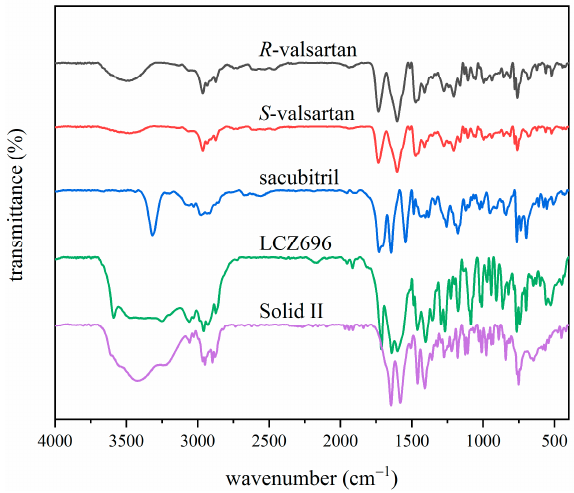
Figure 9. The ATR-FTIR spectra of S -valsartan, R -valsartan, sacubitril, LCZ696 and solid II in solid form.